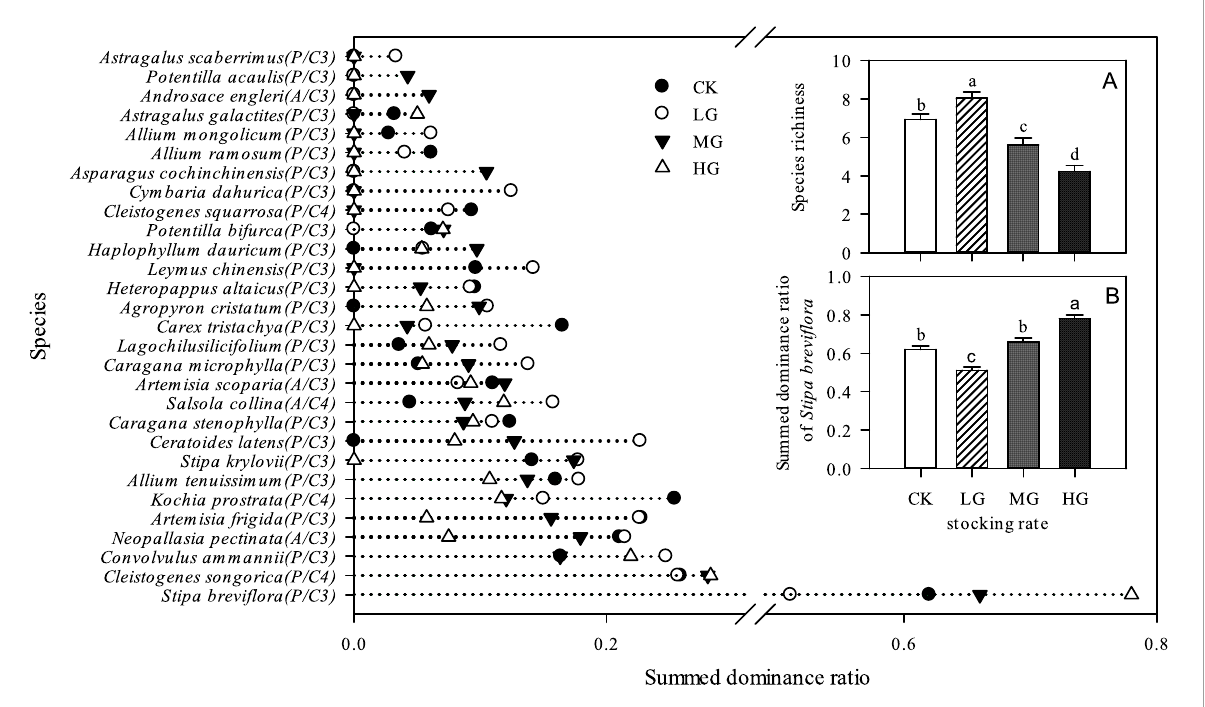
FIGURE1 Ranking of species by summed dominance ratio (SDR), species richness (A) and SDR of Stipa breviflora (B) in areas with different stocking rates. Different letters above bars in panels (A,B) indicate significant differences among treatments ( P < 0.05). P represents perennial species, A represents annual species, and C3/C4 represent C3 or C4